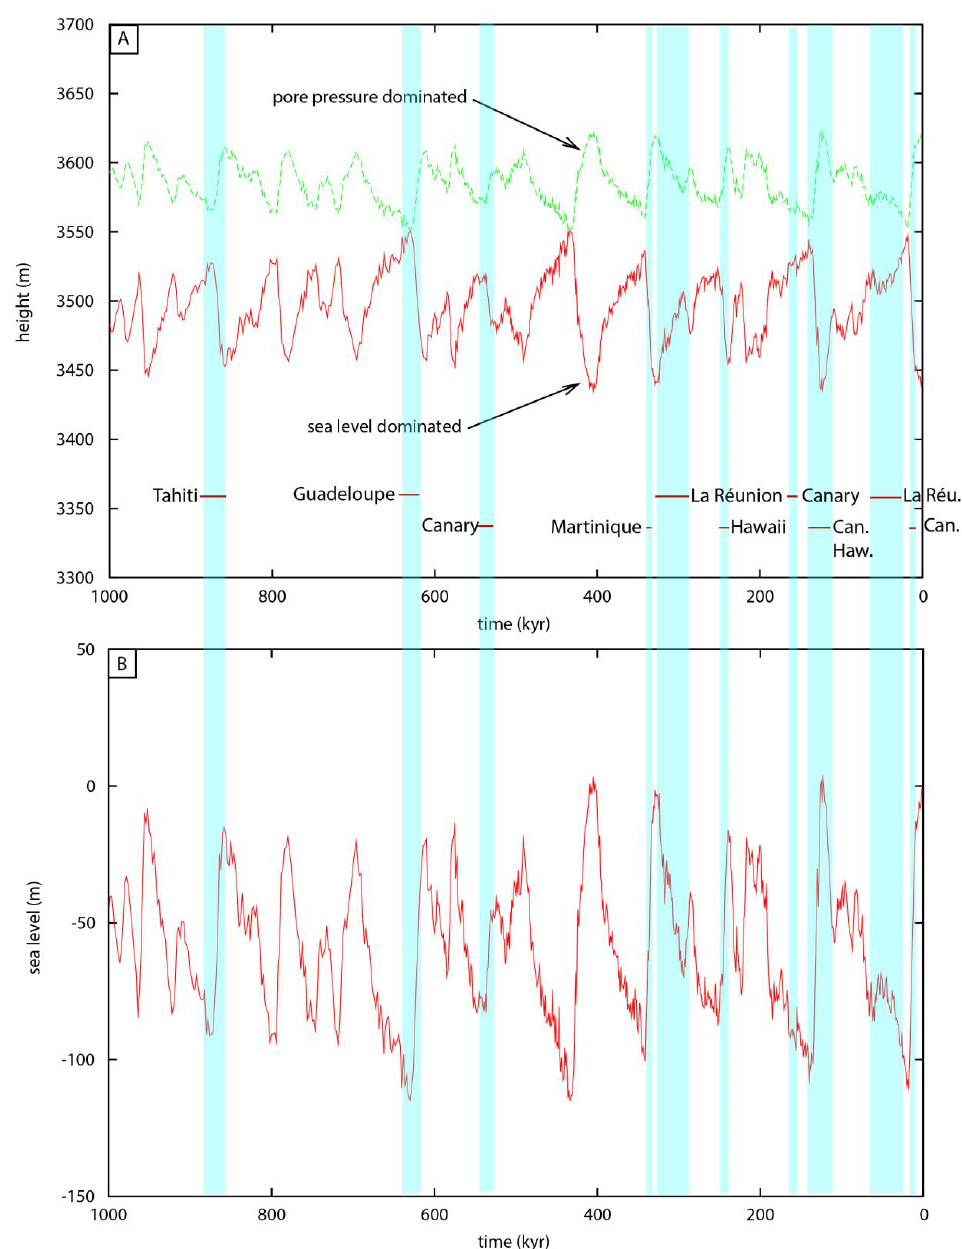
Figure 5. ( A ) Maximum height H before the landslide occurred. The geometry of the island is shown in Figure 4. The effects of sea level loading and pore pressure are simulated. The sea water loading depends on the variation in sea level, while the effect of the pore pressure depends on the fluctuation in precipitation. In the first case (sea level-dominated), the pore pressure is considered to range between 0 and 125 kPa depending on the climatic variation. In the second case (pore pressure-dominated), the pore pressure is assumed to range between 0 and 500 kPa depending on the climatic variation. The absolute values of H are indicative, and only the trends are interpreted in this study. g = 9.81 ms − 2 , C = 1 MPa, φ = 10 ◦ , ρ = 2800 kg/m − 3 , β = 7 ◦ , and a subsidence rate of 0.25 mm/yr are considered. ( B ) Simulated sea level variations during the last million years using the δ 18 O curve of Lisiecki and Raymo [37]. The light blue lines represent the giant landslides on volcanoes during the last 1 Ma of Table